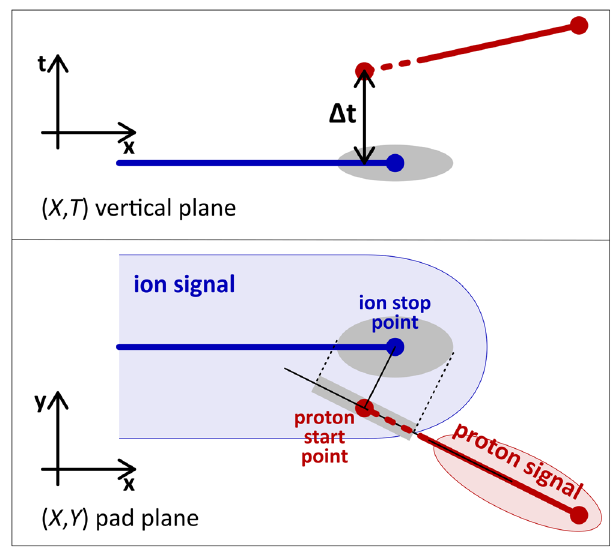
Fig. 5 Illustration of the proton starting point estimate by track extrapolation in the fi t procedure. The starting point is de fi ned in the ( X , Y ) plane by the distance of the proton track extrapolation to the ion stopping point (that is non-zero due to tracks precision), and in the vertical dimension by the corresponding time. The uncertainty on the ion position (grey ellipse) converts into an uncertainty on the proton track